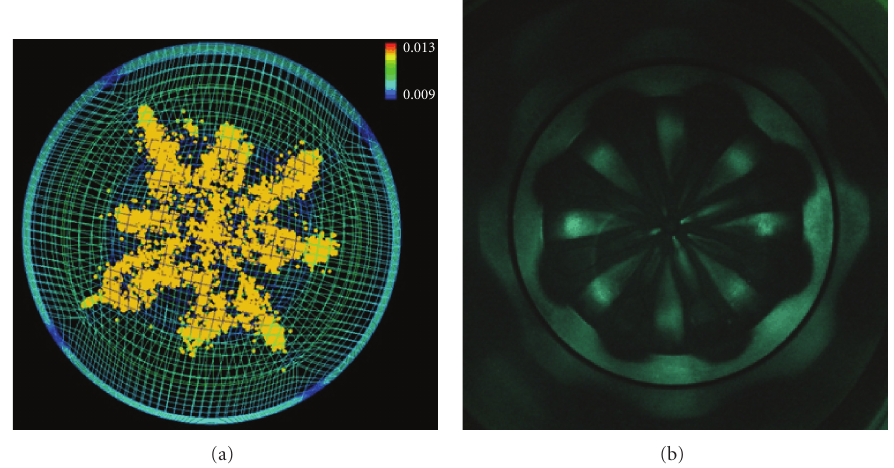
Figure 3: (a) Numerical simulation results and (b) flow pattern